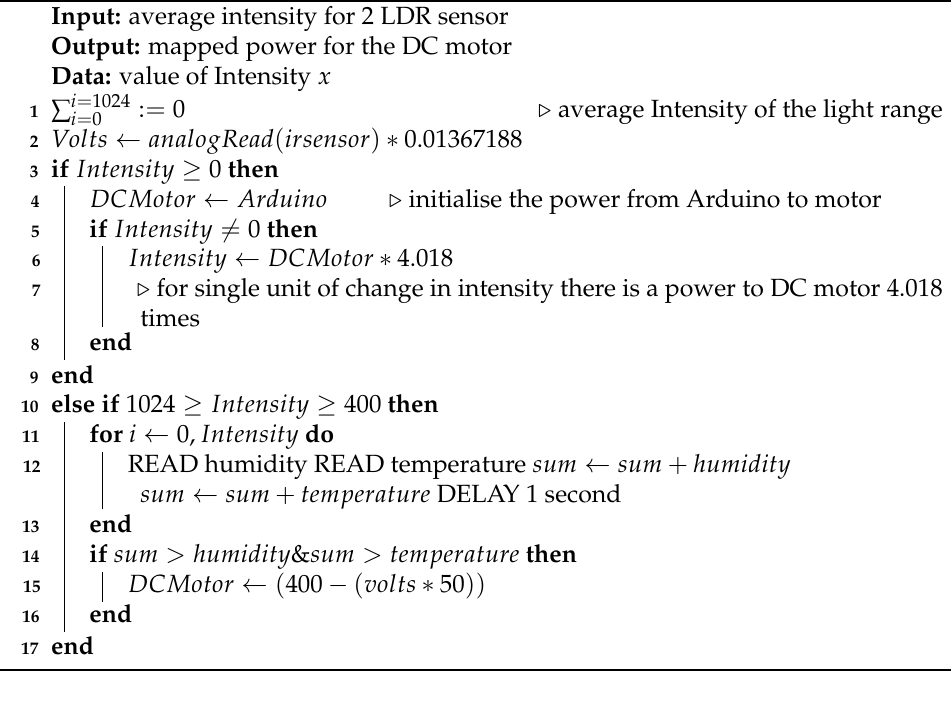
Algorithm 1: An algorithm for detecting the mask fitness.